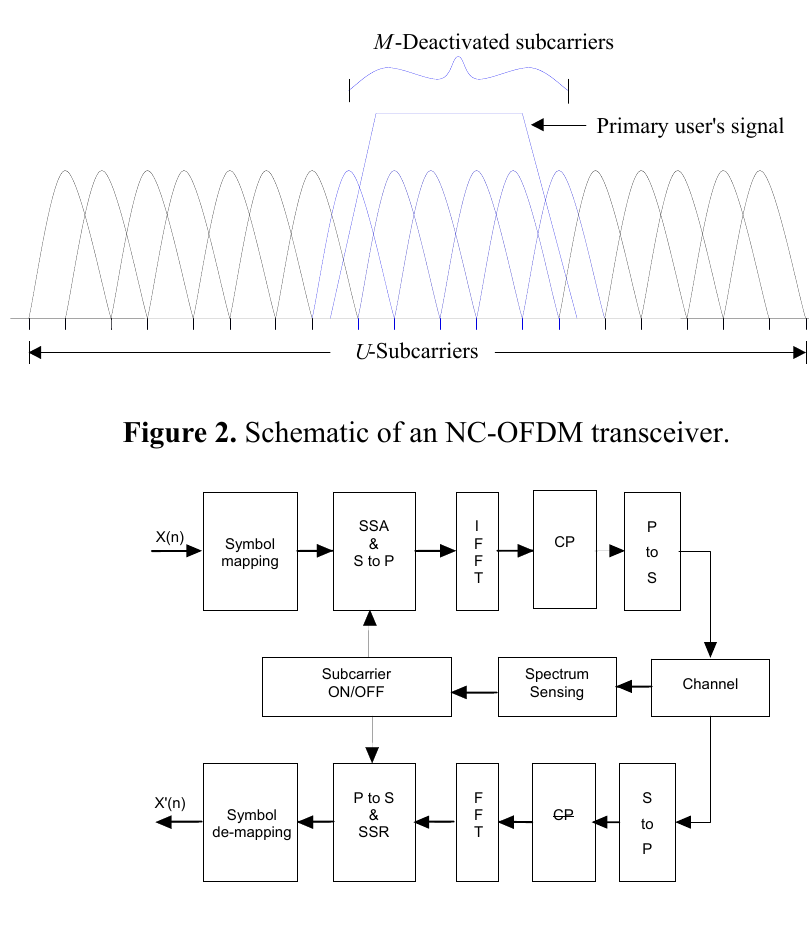
Figure 1. Adaptive subcarrier deactivation in the middle of U subcarriers.